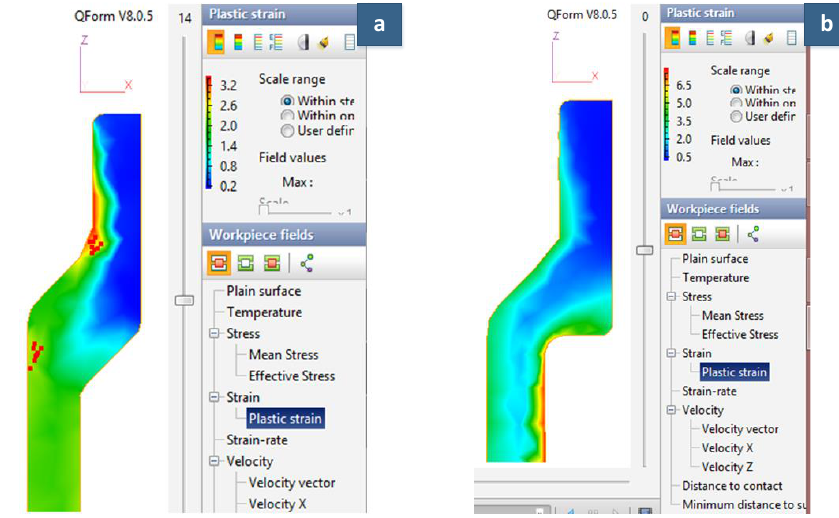
Figure 8. Plastic strain distribution with ( a ) one-step stamping and ( b ) two-step stamping.